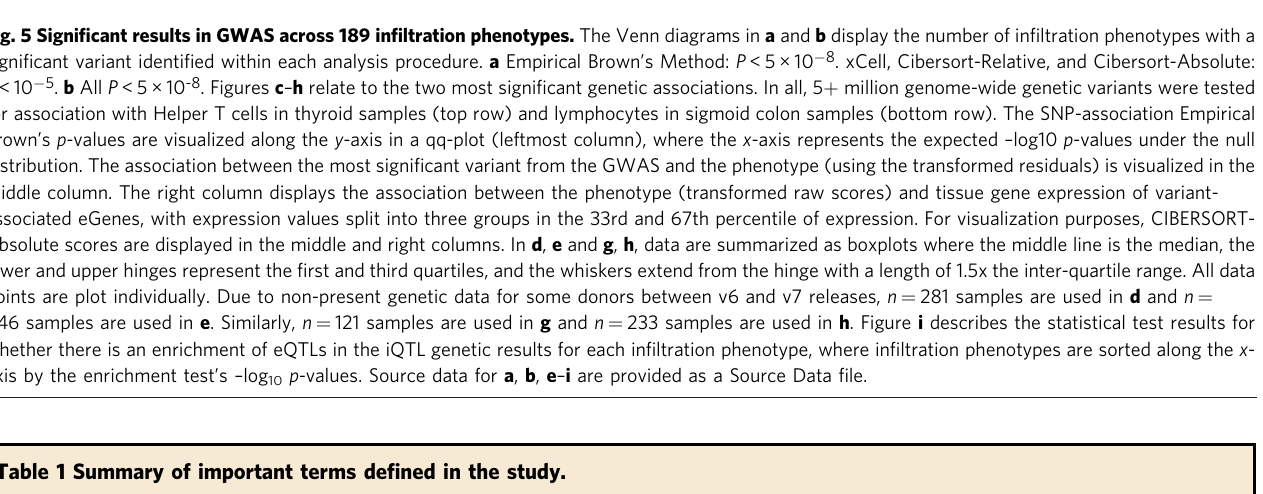
Fig. 5 Signi fi cant results in GWAS across 189 in fi ltration phenotypes. The Venn diagrams in a and b display the number of in fi ltration phenotypes with a signi fi cant variant identi fi ed within each analysis procedure. a Empirical Brown ’ s Method: P < 5 × 10 − 8 . xCell, Cibersort-Relative, and Cibersort-Absolute: P